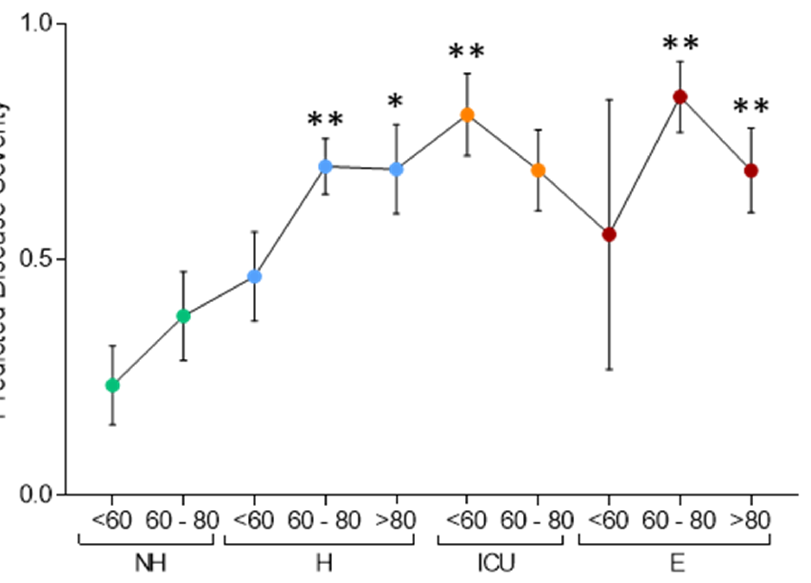
Figure 3. Logistic regression model using selected proteins that correlate with disease progression and severity in the discovery cohort. The panel was constructed with SERPINA3, FGA, PON1, AFM, APOA2 and TTR. The model was trained by logistic regression comparing the NH and E groups. Data are mean ± SEM of the prediction of the model per each individual. Statistical significance ( p -value) is calculated using one-way ANOVA, (* p < 0.05, ** p < 0.01) and all the comparisons refer to <60 years-old non-hospitalized